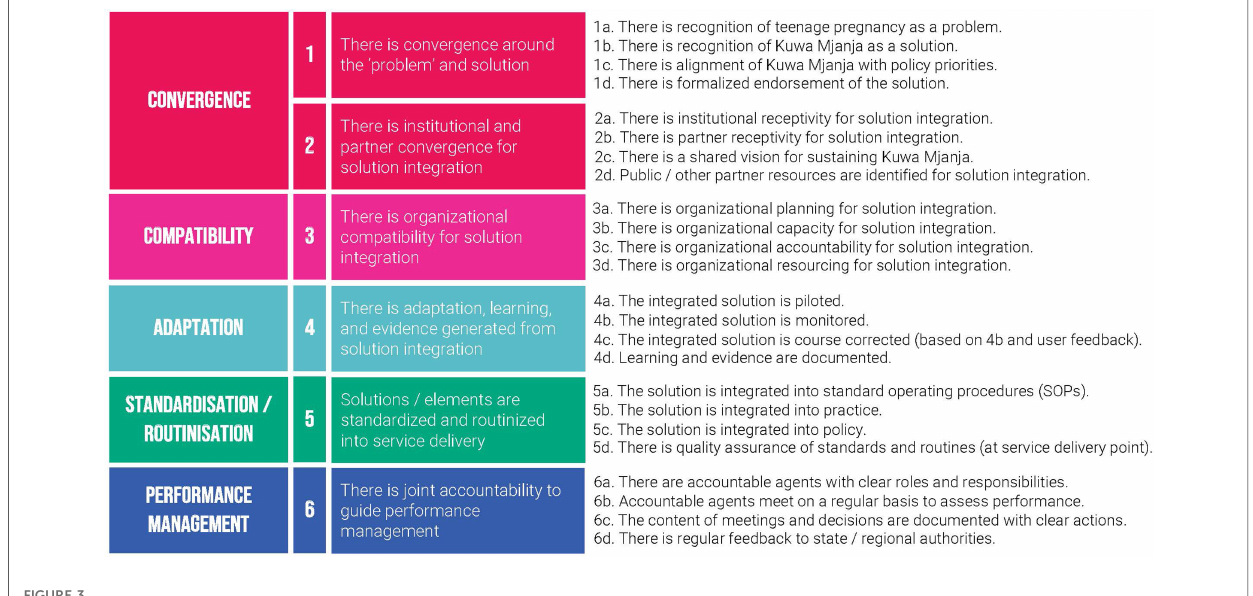
FIGURE 3 A360 institutionalization milestone